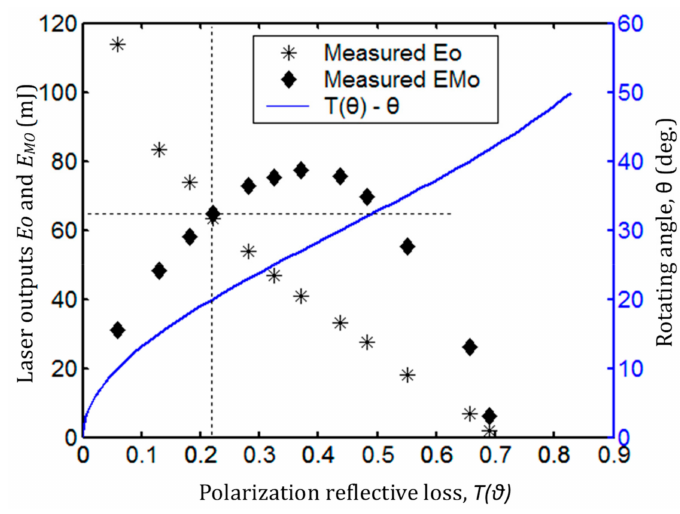
Figure 6. The laser outputs E o and E Mo as a function of the variable polarization reflective loss T ( θ ), and the variable polarization reflective loss T ( θ ) with respect to the rotating angle θ .